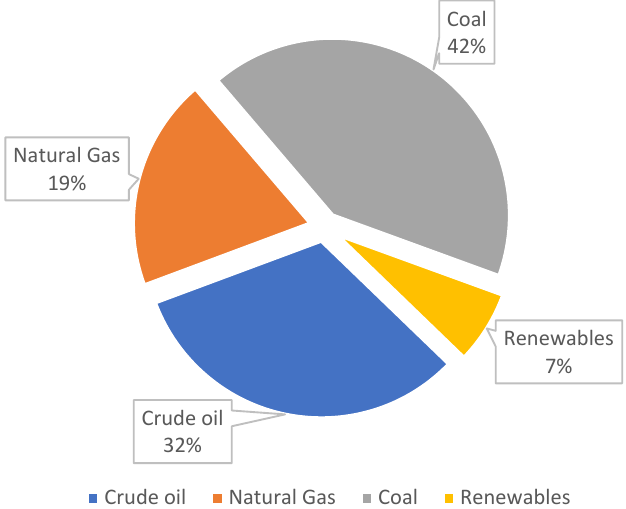
Figure 3. Polish Primary Energy Mix: consumption by fuel, exajoules, own elaboration. The share of coal alone in the energy balance is 78%, and most of it is mined domes-